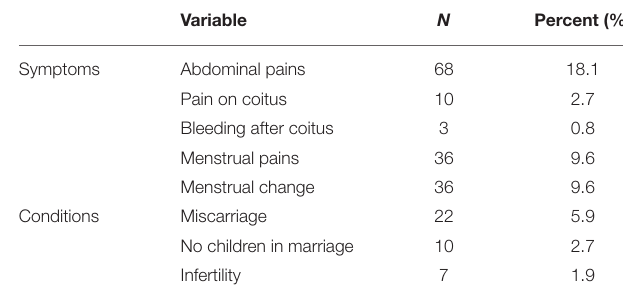
TABLE 8 | Proportion of all 376 participants who reported the symptoms and conditions experienced by their spouses in the preceding months before the study. Variable